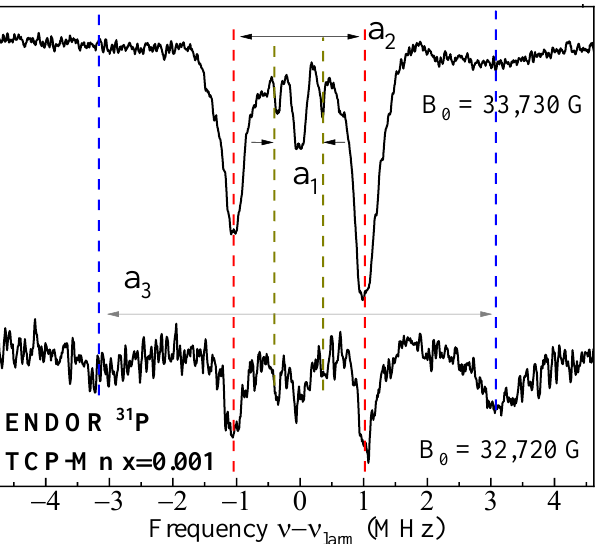
Figure 7. 31 P ENDOR spectrum for 0.001MnTCP (in the region of the Larmor frequency of 31 P). The observed splittings indicate the presence of several positions of Mn 2+ ions in the crystal lattice of TCP. The hyperfine values are a 1 = 0.7 MHz, a 2 = 2.05 MHz and a 3 = 6.4 MHz. The hyperfine structure constants containing two different contributions related to dipole-dipole interaction (anisotropic part) and to Fermi contact interaction (isotropic part) were used to estimate the interatomic distance between Mn and 31 P. In point dipole approx- imation the distance can be estimated as 3–4 Å. The intensity redistribution depending on a fixed external magnetic field is caused by angular dependence of the splitting value related to anisotropic dipole-dipole interaction. In addition, manganese has a weak spatial electron density distribution on phosphorus nuclei, since all the electron density is concentrated on the ion itself. Thus, the contribution of Fermi contact interaction is negligibly small and is not considered in